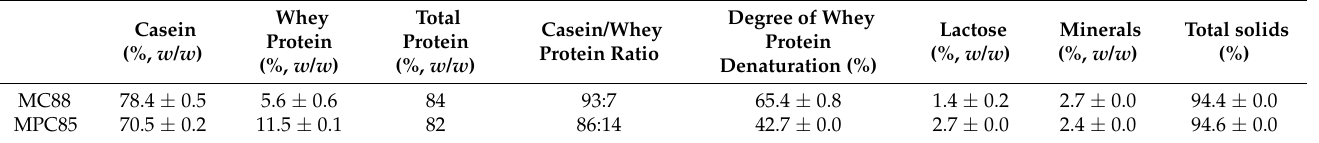
Table 1. Powder compositions of MC88 and MPC85 (mean ± standard